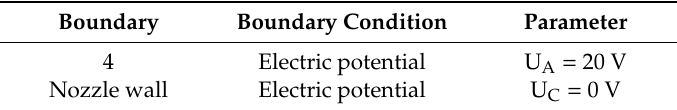
Table 3. Boundary conditions for simulations of